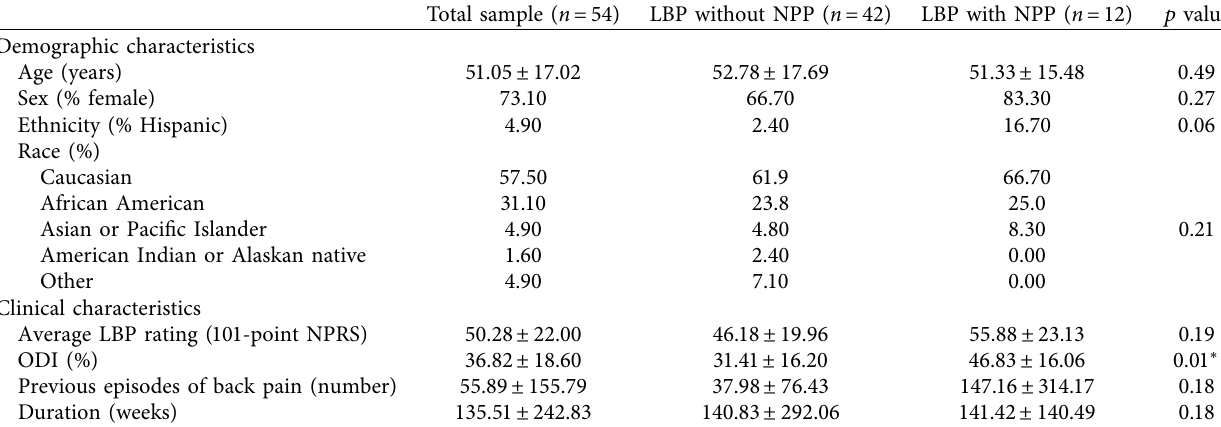
Table 1: Baseline demographic and clinical characteristics for the total sample and by the group.